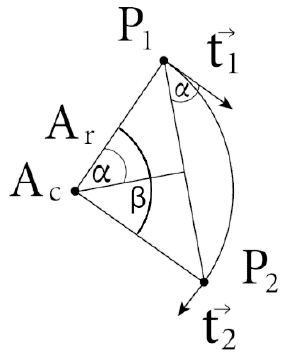
Figure 6. The i -th arc model.